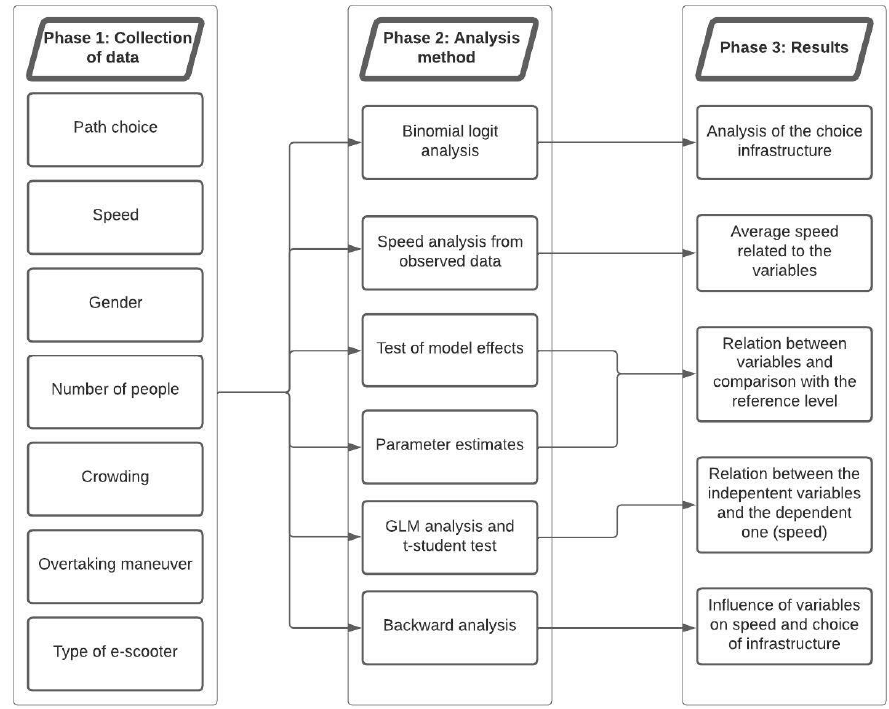
Figure 5. Flow chart of the research